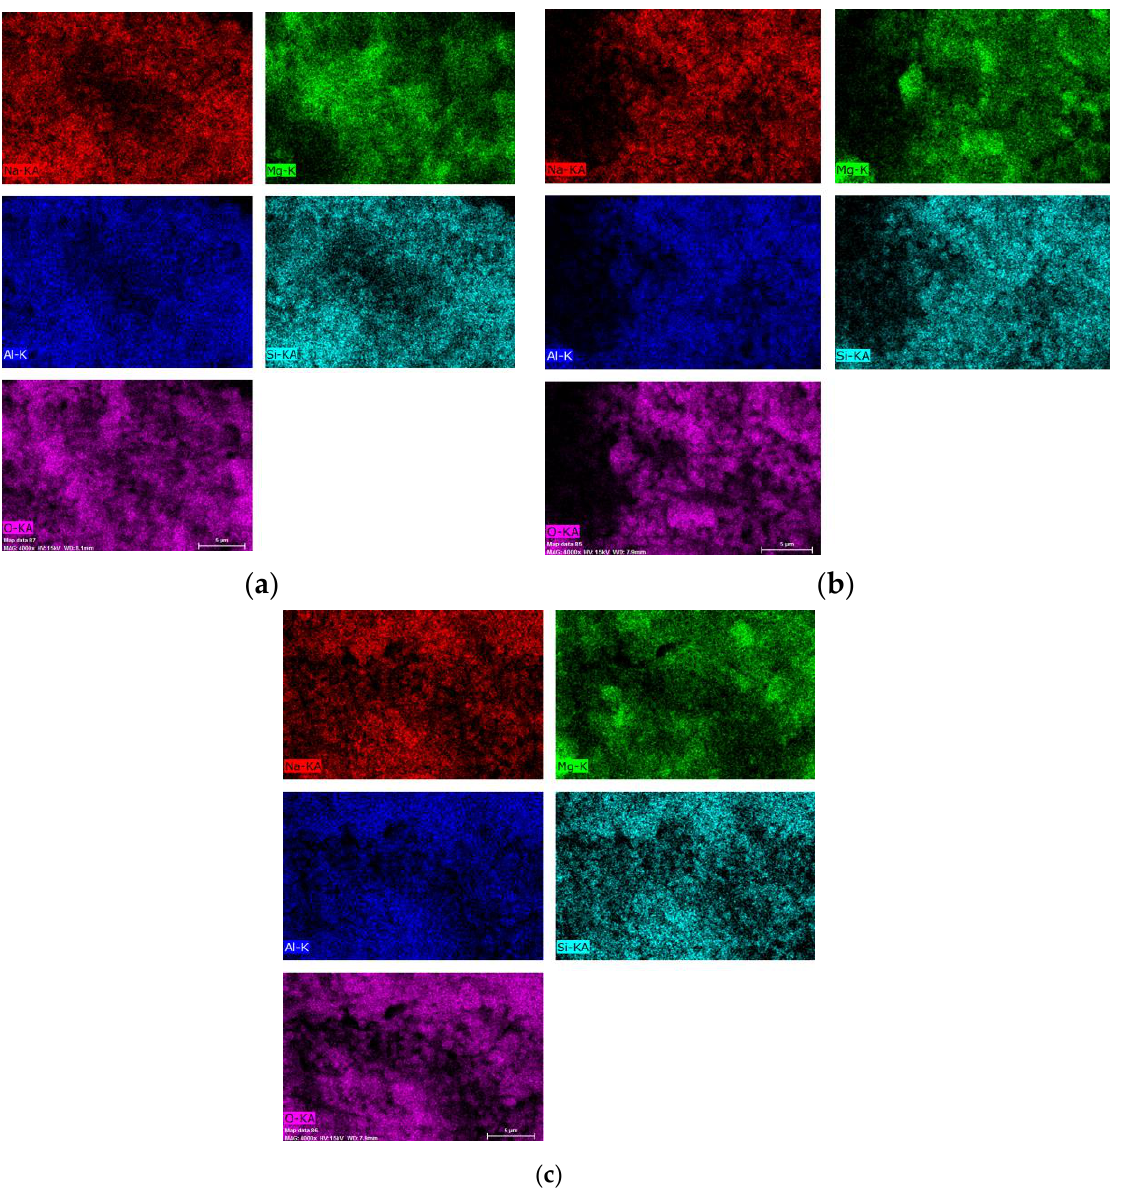
Figure 8. Micrograph of the calcined and rehydrated samples: ( a ) calcination under He flow at 300 °C, ( b ) calcination under O 2 flow at 300 °C, and ( c ) calcination under O 2 flow at 500 °C.